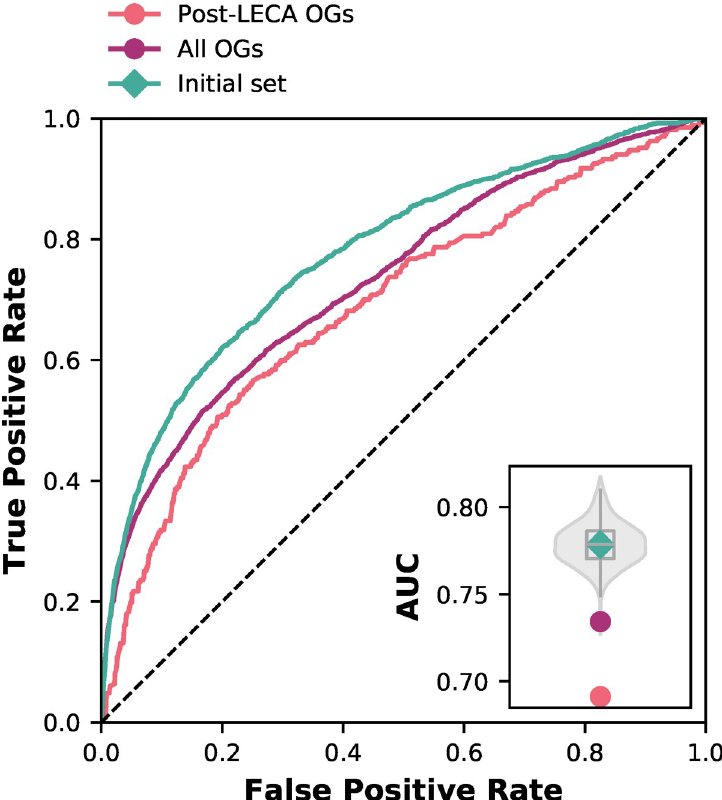
Fig 5. Orthologous group selection has a large impact on prediction performance. Receiver-operator Curve of post- LECA OGs and unfiltered OGs. The inset gives the Area Under the Curve (AUC) values compared with the random backdrop of randomly selected LECA OGs (violin plot) and the initial species set (green diamond). S8 Fig shows the results for Broccoli OGs.